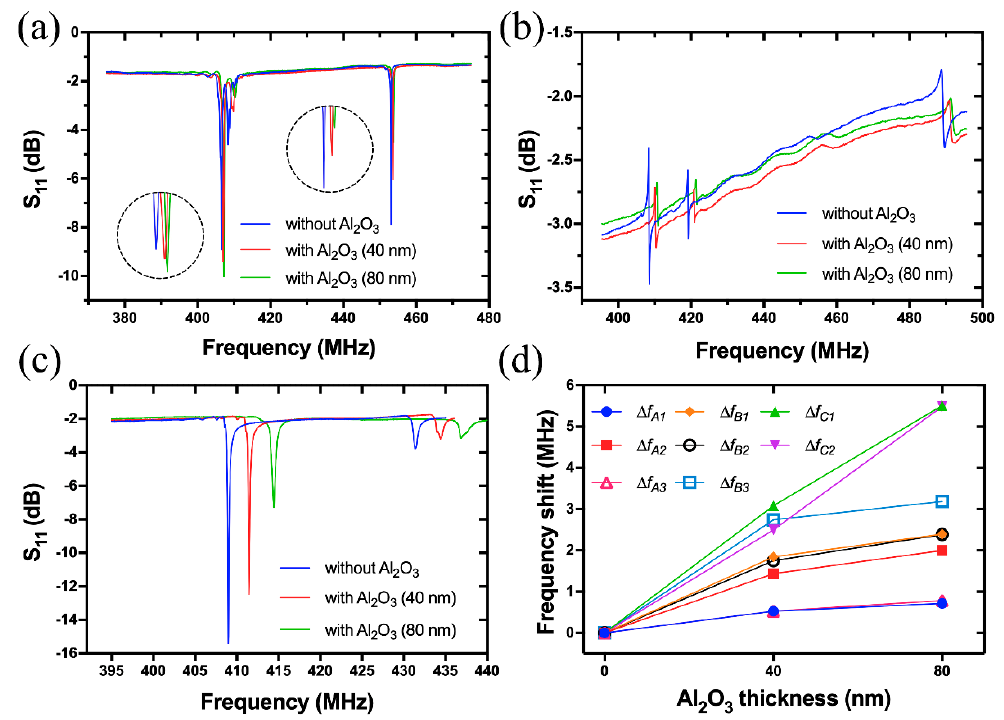
Figure 8. Effects of Al 2 O 3 passivation layer with different thicknesses on the reflection spectra of Device A ( a ), Device B ( b ) and Device C ( c ); Frequency shift of each resonant peak as a function of Al 2 O 3 layer thickness ( d ).